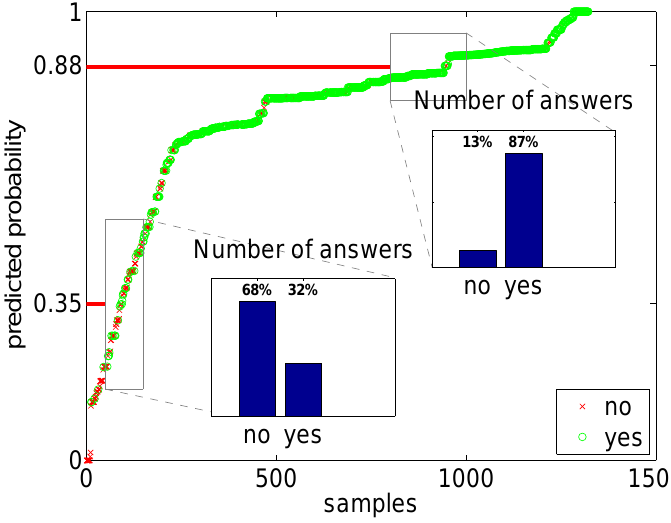
Figure 8. Predicted yes -probability for each sample in the sorted activities data. The small bar plots tell how many yes and no answers there are inside the two small rectangural areas.